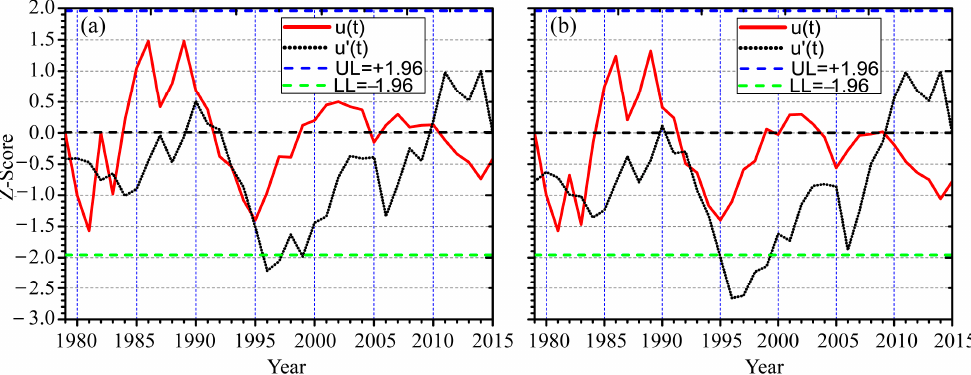
Figure 10. Abrupt changes of ( a ) annual and ( b ) seasonal precipitations over Malawi as derived from the SQMK test. )( tu is progressive sequential while )( tu the SQMK test. u ( t ) is progressive sequential while u ( t (cid:48) ) is retrogressive sequential statistics. The higher statistics. The higher and lower dashed lines exhibit the corresponding value of ±1.96 at the 95% and lower dashed lines exhibit the corresponding value of ± 1.96 at the 95% confidence confidence level.